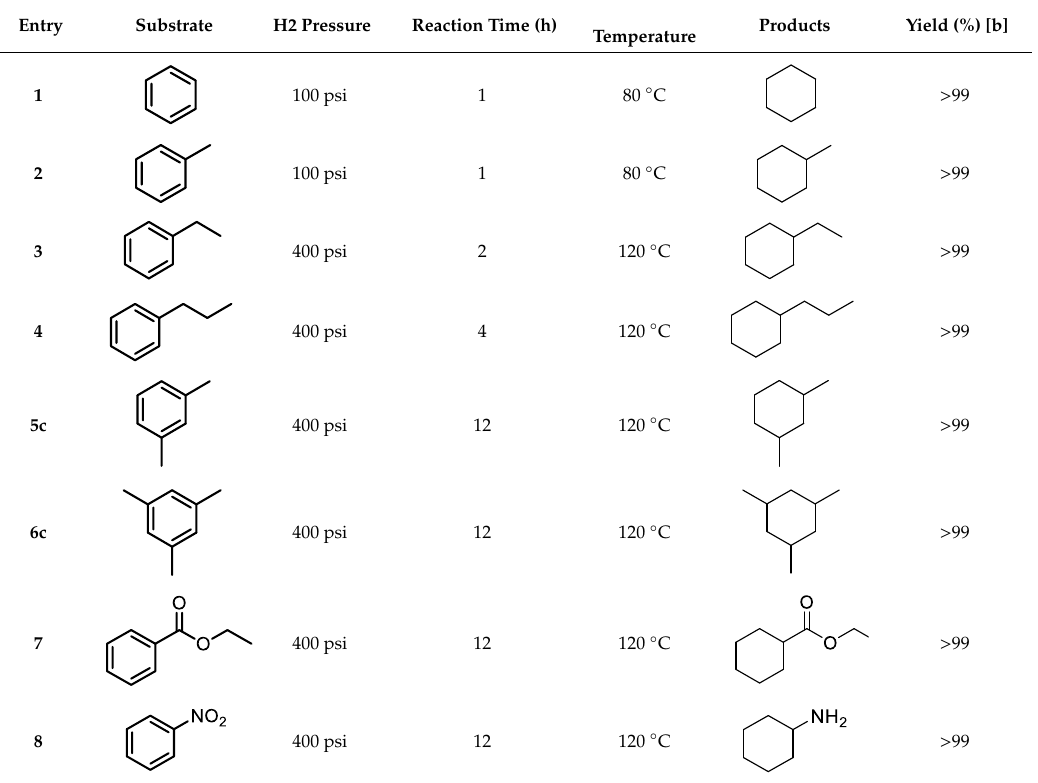
Table 2. Reduction of toluene mediated by the Ru@M-Ethylene PMO NP catalyst. [a]. Entry.